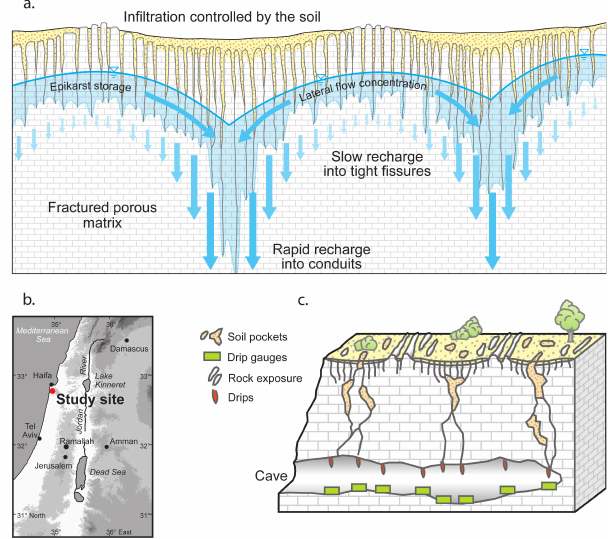
Fig. 1. (a) Conceptual model of the epikarst (after Williams, 1983, modified, blue: temporarly stored water, yellow: soil and dissolution residuals), (b) location of the study site, and (c) schematic descrip- tion of the study site (after Arbel et al., 2010,